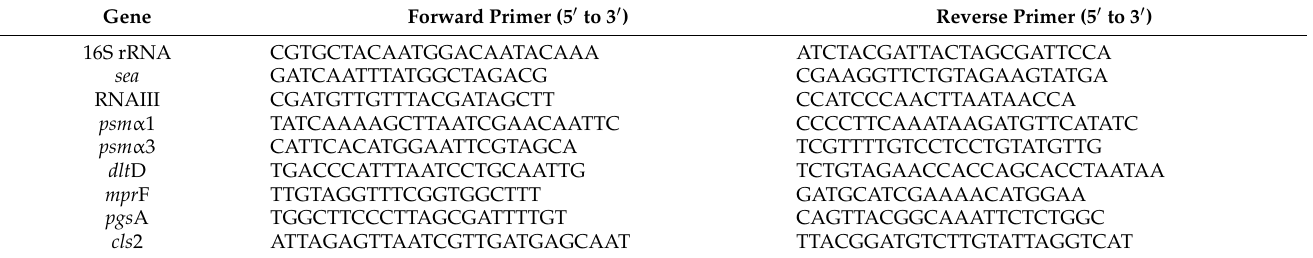
Table 1. The sequences of the primers used for the gene expression of Staphylococcus aureus